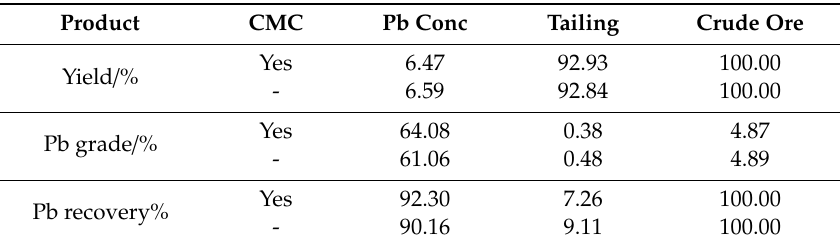
Figure 12. Flow-sheets of closed-circuit tests. Table 8. Results of closed-circuit test.